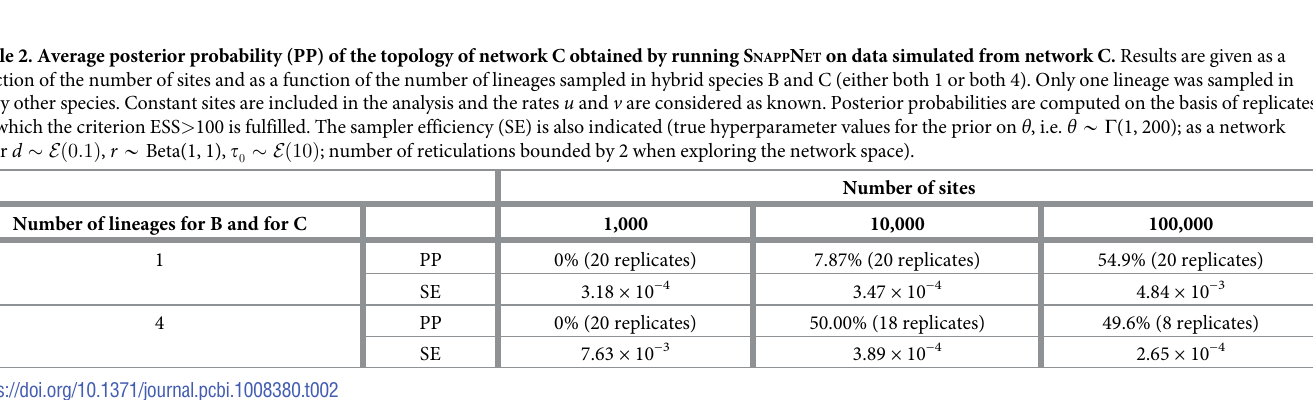
Table 3. Average posterior probability (PP) of the topology of network C obtained by running MCMC_BiMarkers on data simulated from network C. Results are given as a function of the number of sites and as a function of the number of lineages sampled in hybrid species B and C (either both 1 or both 4). Only one lineage was sampled in every other species, constant sites are included in the analysis, and the rates u and v are considered as known. 1.5 × 10 6 iterations are considered. ESS is the aver- age ESS over the different replicates, and SE stands for the sampler efficiency.